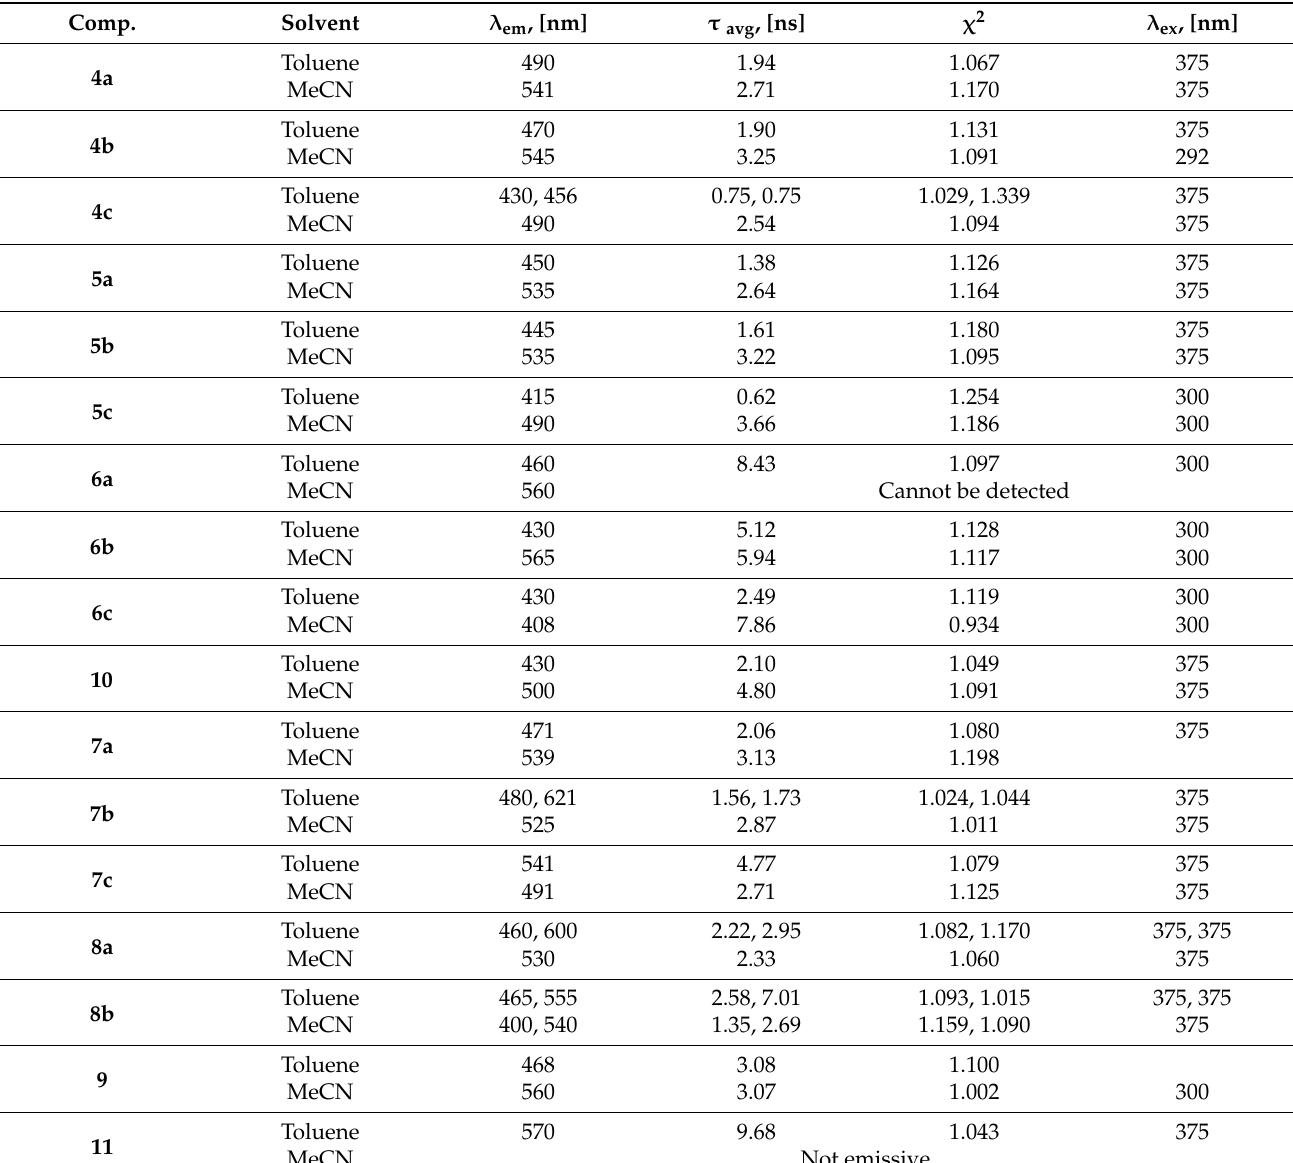
Table 2. Data of the fluorescence lifetime measurements of 4a–c , 5a–c , 6a–c , 10 , 7a–c , 8a,b , 9b , 11 : τ avg —average lifetime, χ 2 —chisquared